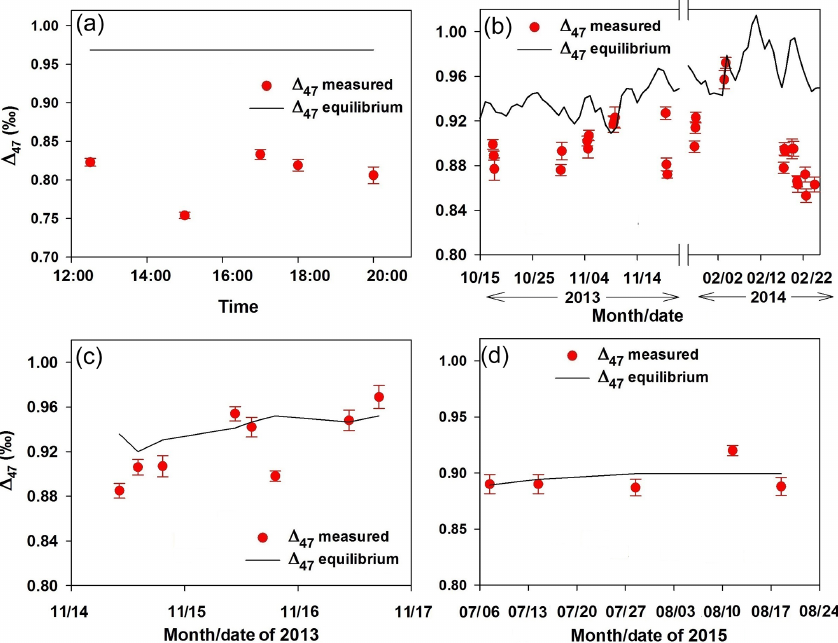
Figure 7. (cid:49) 47 values in the near-surface atmospheric CO 2 from (a) urban site near Roosevelt Road on 30 December 2015, (b) suburban station (Academia Sinica Campus), (c) grassland in the National Taiwan University Campus and (d) forest site near the Academia Sinica Campus. The error bars are the 1 standard error associated with the measurements. Lines show (cid:49) 47 values for the CO 2 at thermodynamic equilibrium at ambient